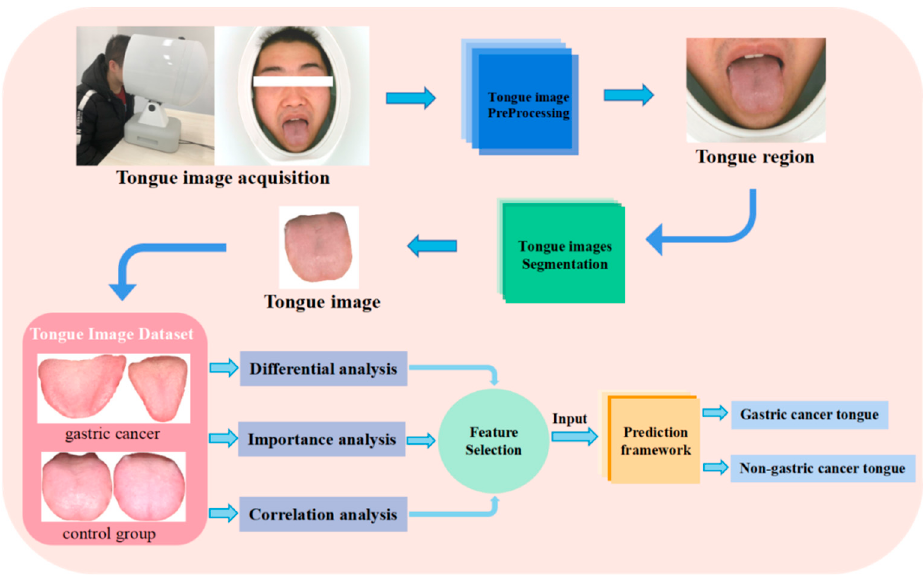
Figure 1. Overview of our framework.